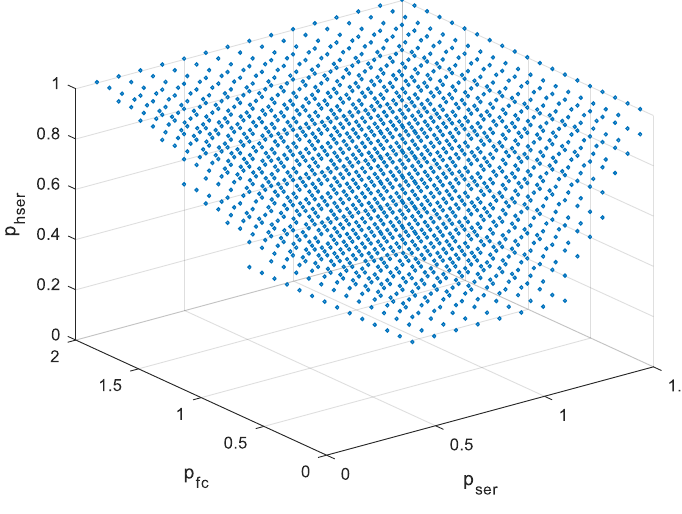
Figure A3. The tripartite game Nash equilibria diagram for r > Q